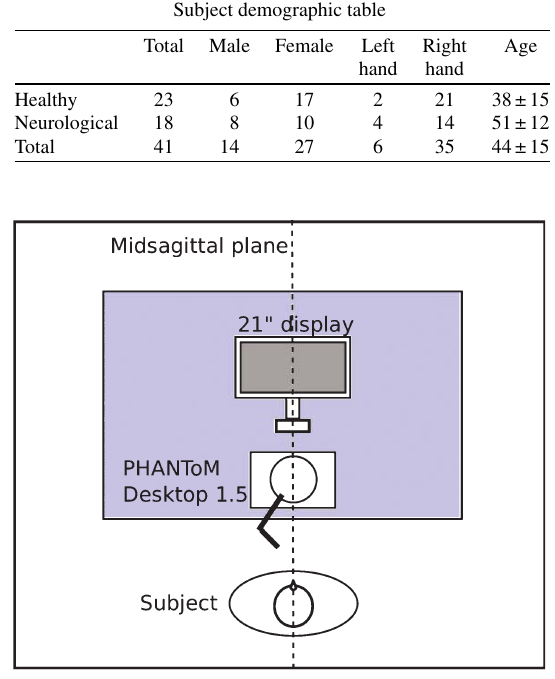
separation distance between holes and clearance (peg vs. hole). The peg collision with the holes and the other solid surfaces such as walls shown by Fig. 1 is detected by detecting collision between these objects and slices of the peg, which are sectioned as shown by dots in Fig. 2. Using a novel mathematical collision detection algorithm, multiple contacts between the peg, the table and holes are detected and haptic feedback is produced upon collisions.